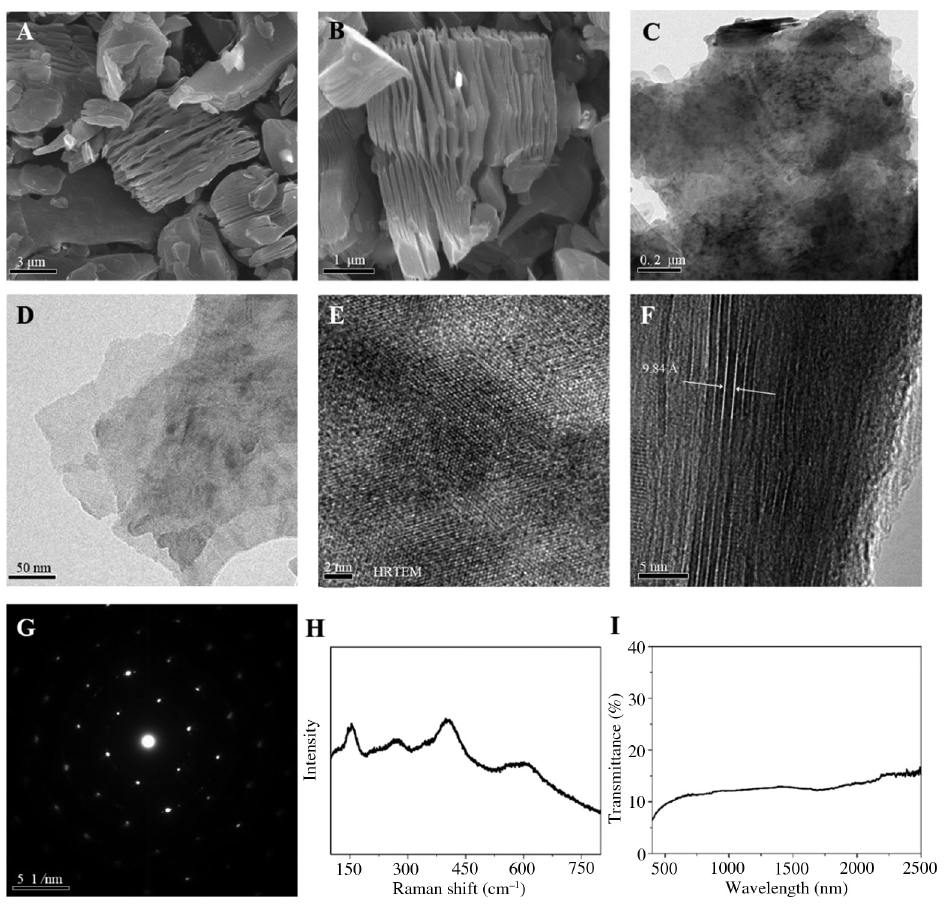
C T . 3 2 x C T after HF etching. (C, D) TEM images of Ti 3 2 x